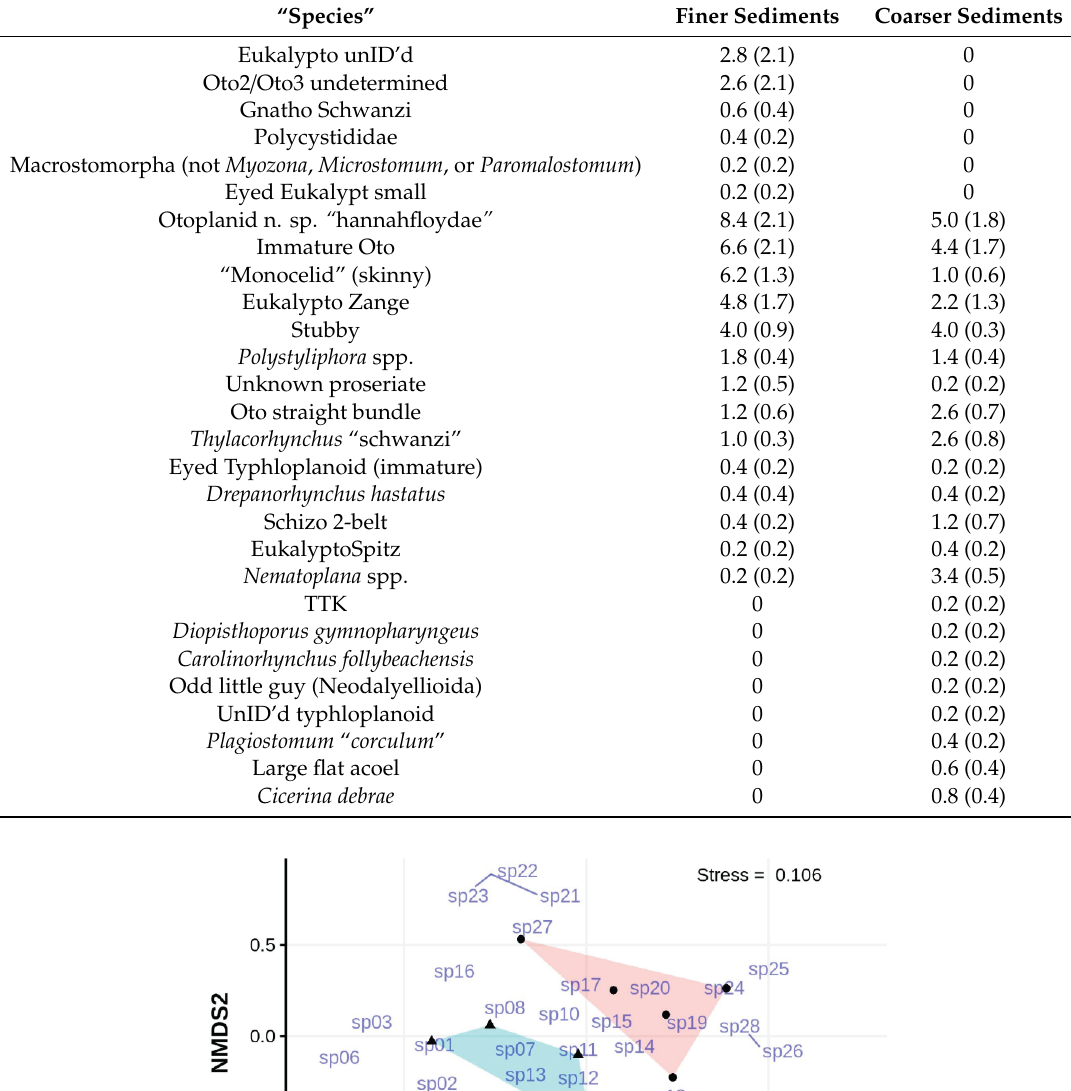
Table 7. Turbellarian species (undescribed species listed with helping names) found in finer and coarser sediments in the lower intertidal of EI in March 2012. Numbers represent the mean ( ± 1 SE) number of individuals per 25 mL.